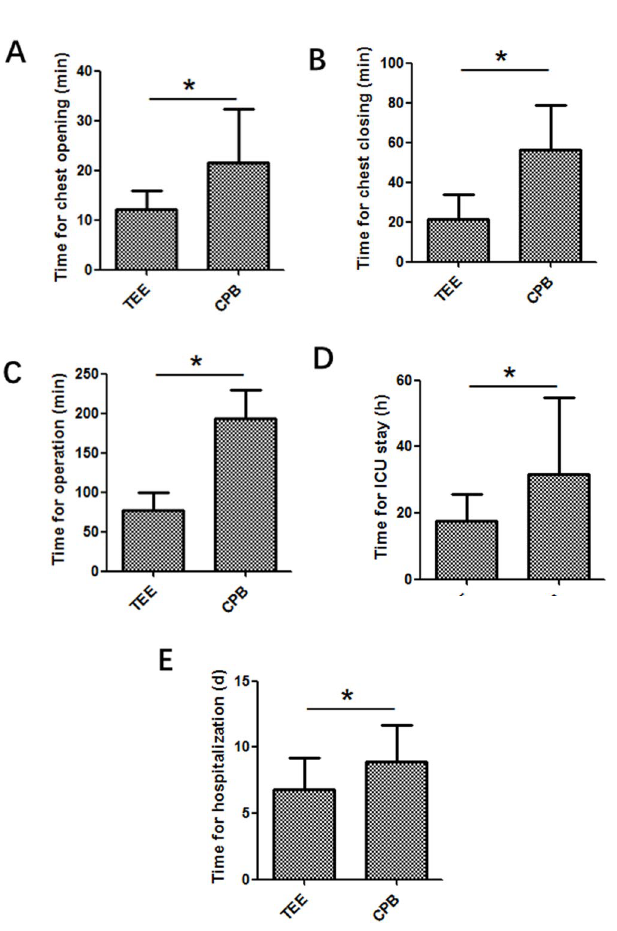
Fig. 4 - Volume of drainage (A), length of incision (B), cost of blood infusion (C) and full cost (D). Mean ± standard deviation. Two groups were compared using independent samples t test, *P<0.05 for statistical